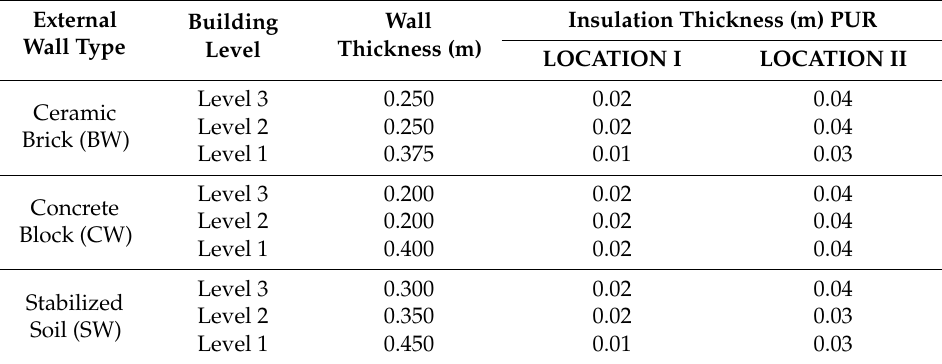
Figure 2. Climate types in Spain according to CTE-DB-HE [38]. Table 1. Thickness of the load-bearing walls and insulation thickness for the different levels.